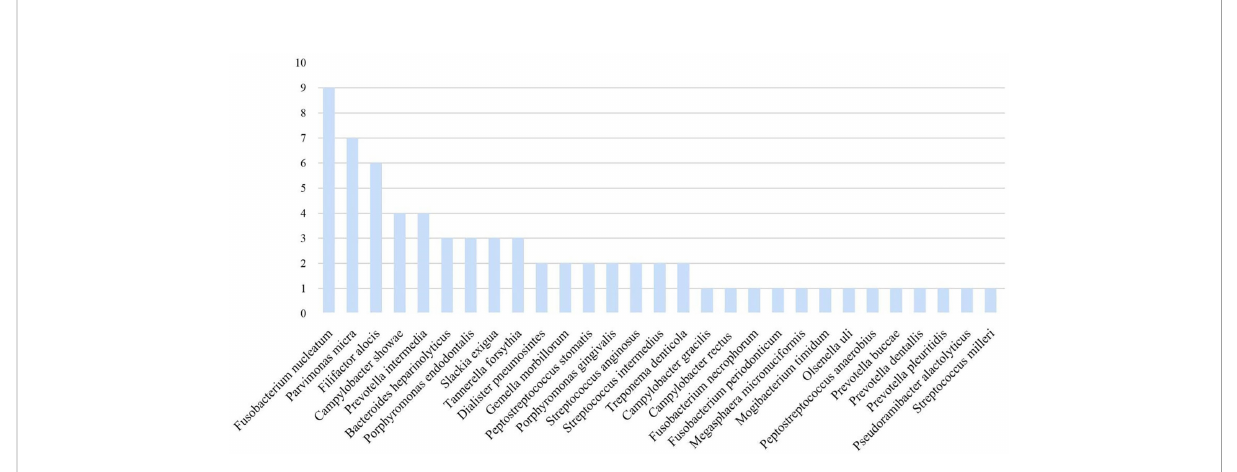
FIGURE 1 Species distribution of pathogens detected by pleural effusion mNGS.